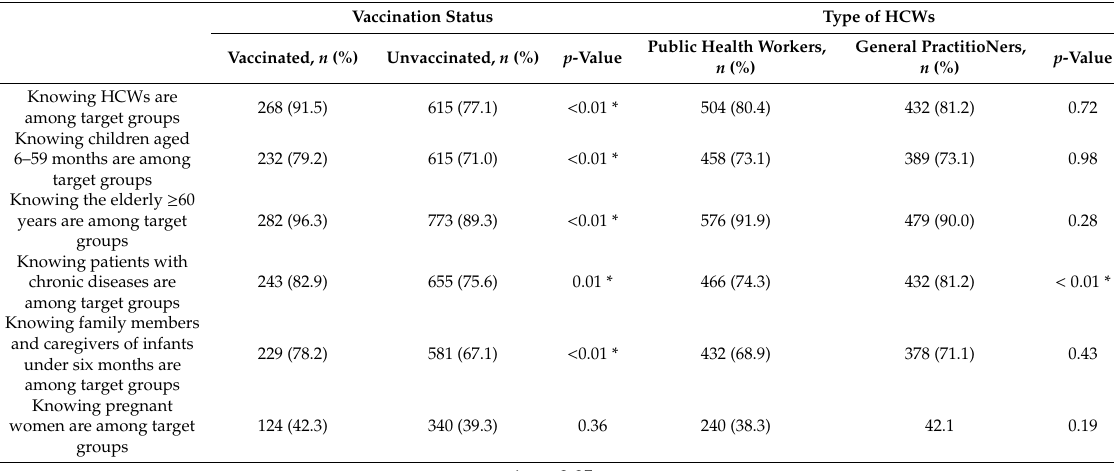
Table 3. HCWs’ knowledge of di ff erent target groups for influenza vaccination.